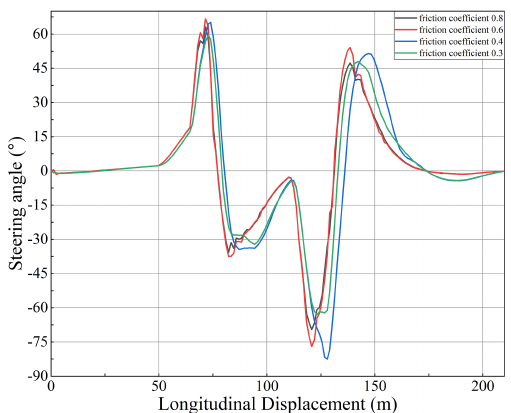
Figure 12. Yaw rate at different speeds.